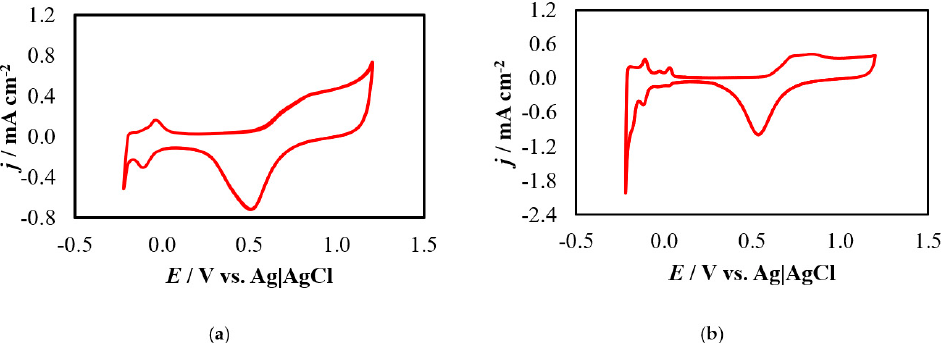
Figure 3. Cyclic voltammogram (CV) obtained using the rotating disk electrodes with ( a ) state-of-the-art Pt/C catalyst and ( b ) Pt/Ti 9 O 17 catalyst in N 2 -saturated 0.5 M H 2 SO 4 solution at a scan rate of 25 mV s − 1 .